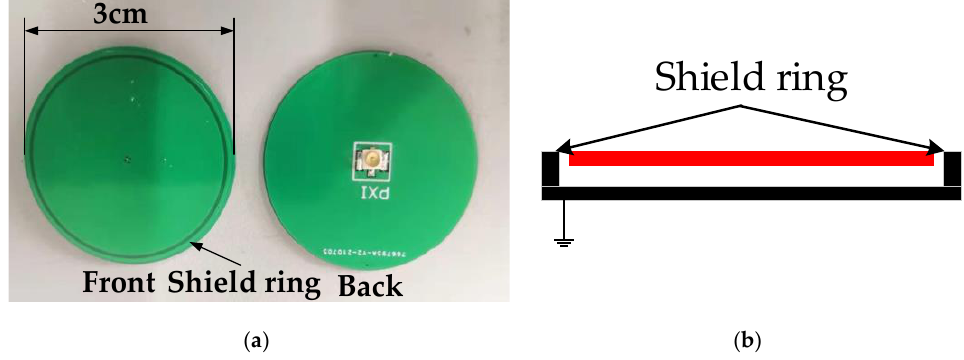
Figure 17. Electric field sensor: ( a ) Physical view of the sensor; ( b ) Schematic diagram of the sensor structure.